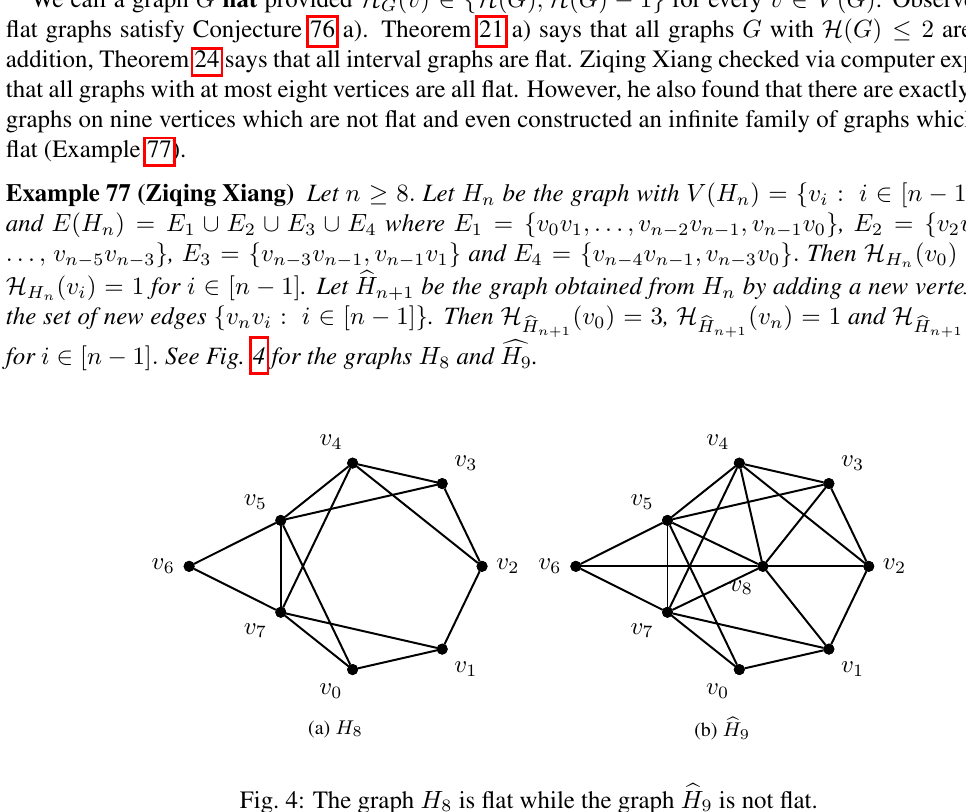
is flat while the graph (cid:98) H 8